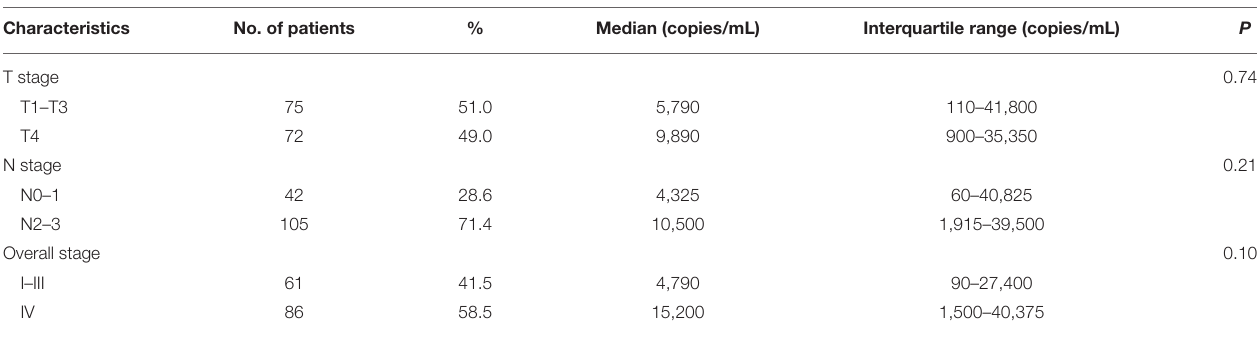
TABLE 2 | Associations between pretreatment EBV DNA and TNM staging.